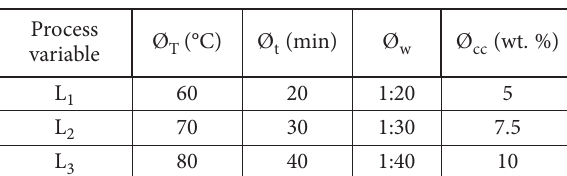
Table 1. Self-governing process parameters for one-pot